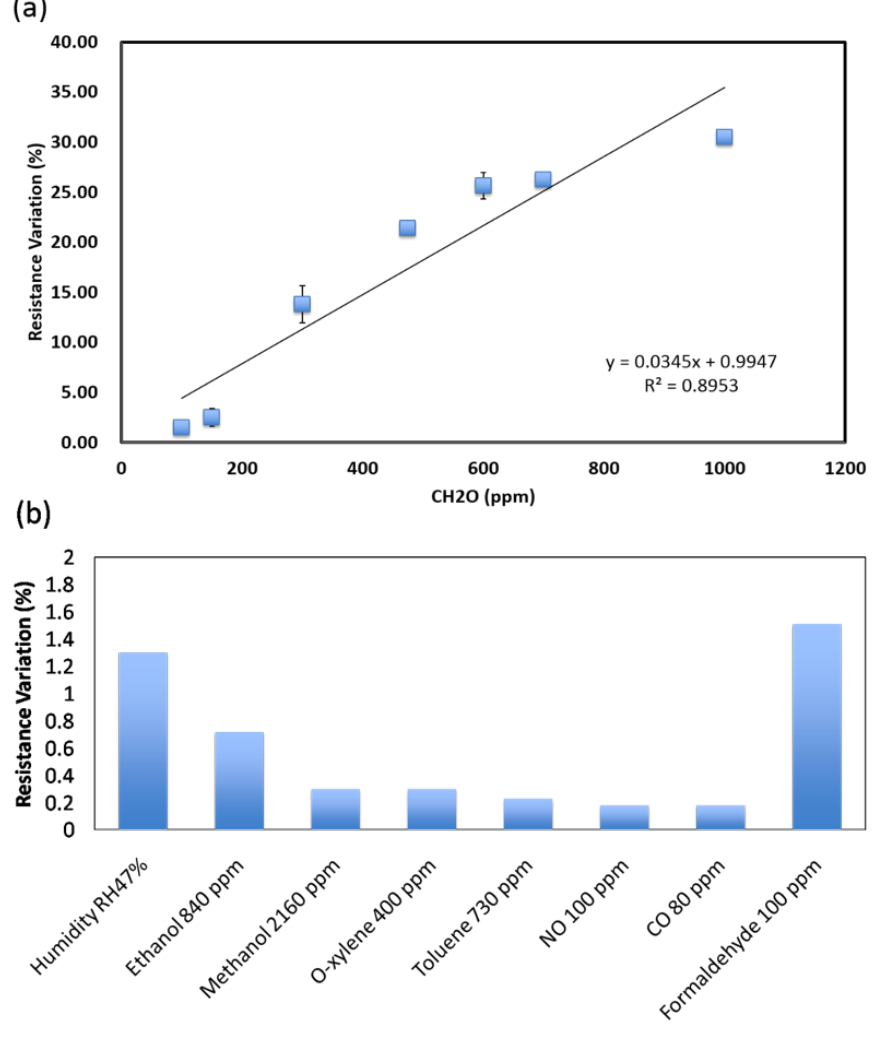
Figure 4. The characteristics of 2% RGO/ 10% PMMA sensing material operated at room temperature for: ( a ) formaldehyde sensitivity and ( b )